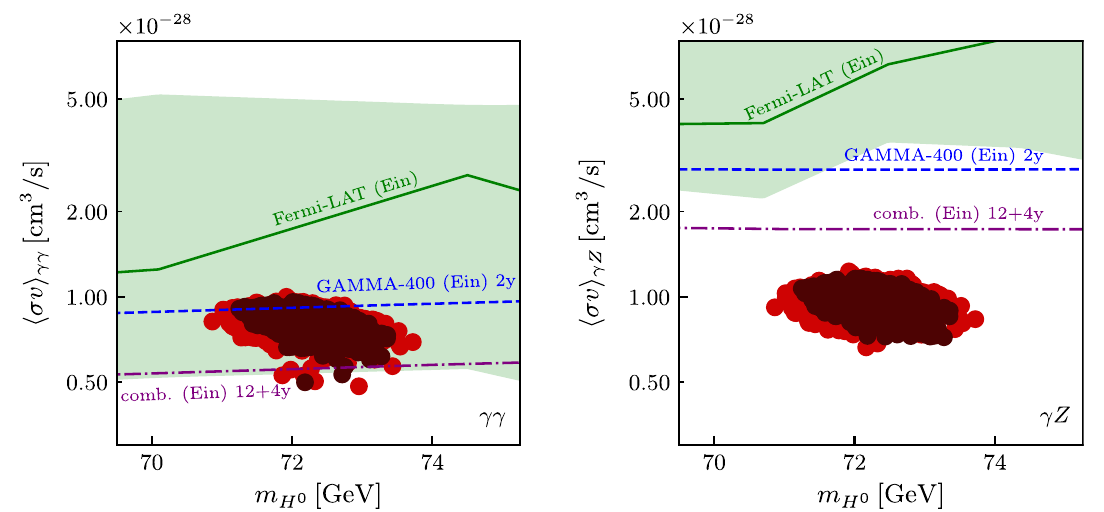
green shaded band shows the respective limits for NFWc and isother- mal profile, respectively. The blue dotted and purple dot-dashed curves show projections for GAMMA-400 (2 years) and the combination of Fermi-LAT (12 years) and GAMMA-400 (4 years), respectively, both assuming the Einasto